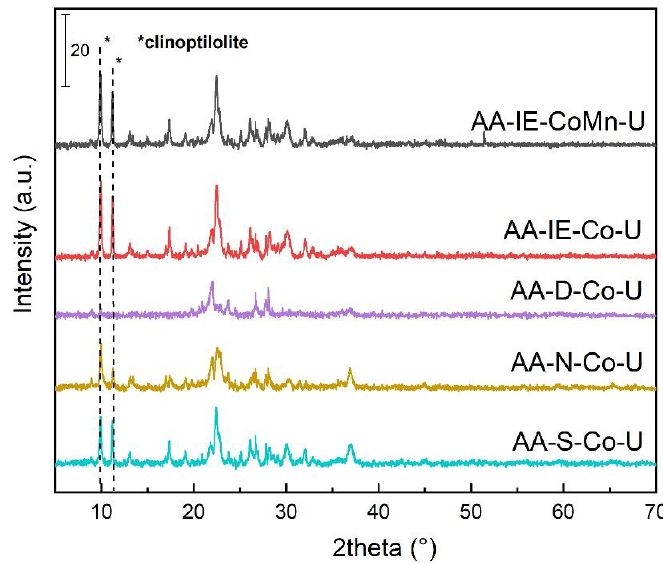
Figure A3. Powder diffraction patterns of used cobalt catalysts.